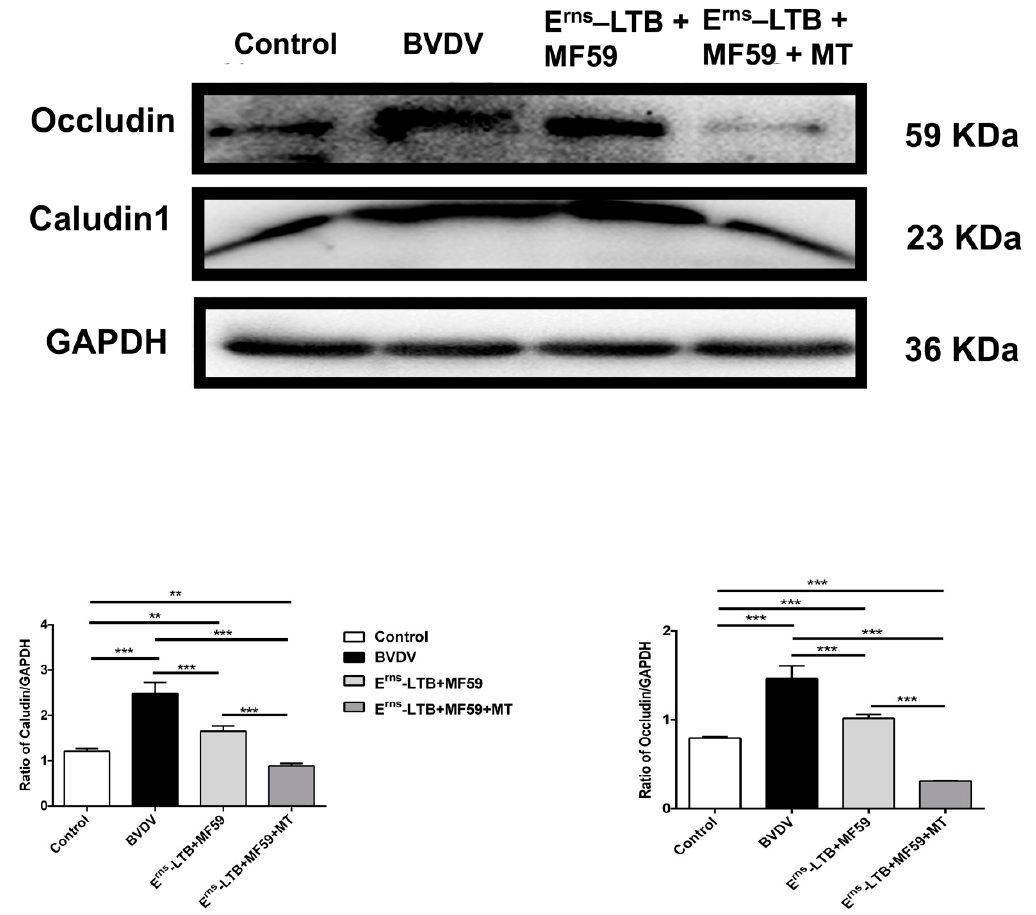
Figure 5. Comparison of the claudin-1 and occludin expression levels in vivo. Relative protein expression levels were based on western blot band intensity; protein levels were normalized with GAPDH. Representative western blot image of claudin-1 and occludin expression levels in mice. The values in each column represent the mean ± SEM of three individual mice from each group detected in triplicate. ** p < 0.01; *** p < 0.001.